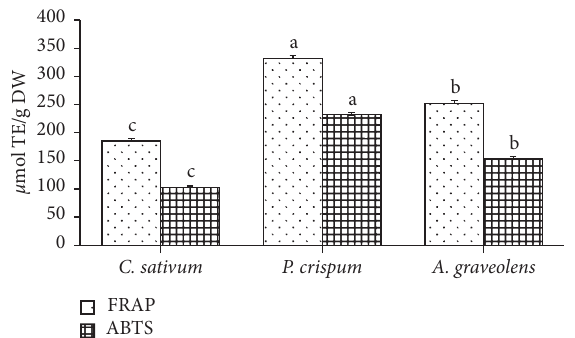
Figure 3: Antioxidant activity of the studied plant species based on FRAP and ABTS assay. Amounts are mean ( n � 6) ± SE. bars fol- lowed by different lower-case letters (a–d) which are significantly different ( p < 0 . 001).